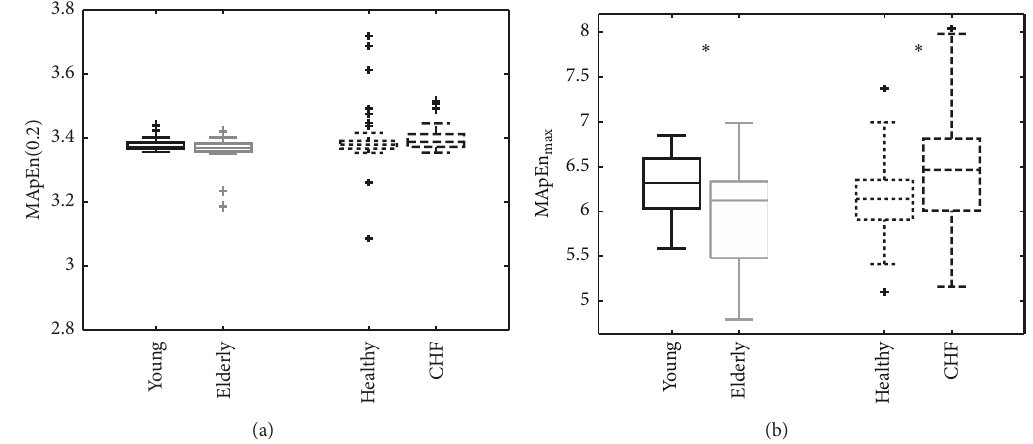
Figure 7: (a) MApEn(0.2) and (b) 𝑀𝐴𝑝𝐸𝑛 𝑚𝑎𝑥 values computed for young (solid black) versus elderly (solid grey), and healthy subjects (dotted) versus CHF patients (dashed). ∗ indicates statistically significant differences by Mann-Whitney U test ( p -values < 0.05) between groups. Data are shown as median and interquartile